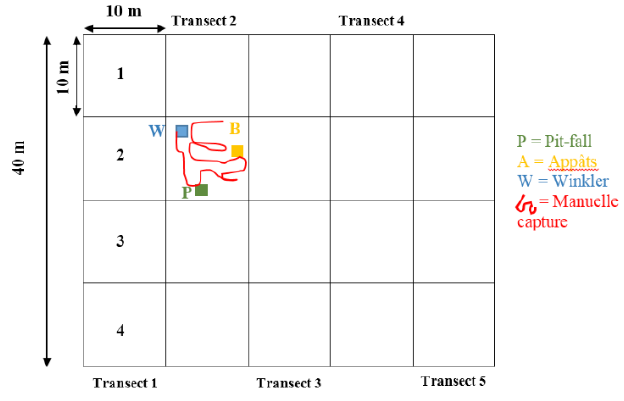
Fig 2 . Experimental protocol for each sampled environment (Groc, 2006).